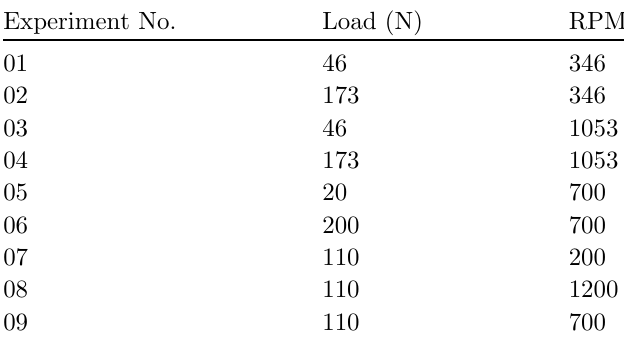
Fig. 2. Pins of Al6061. Table 2. Design of experiment for wear